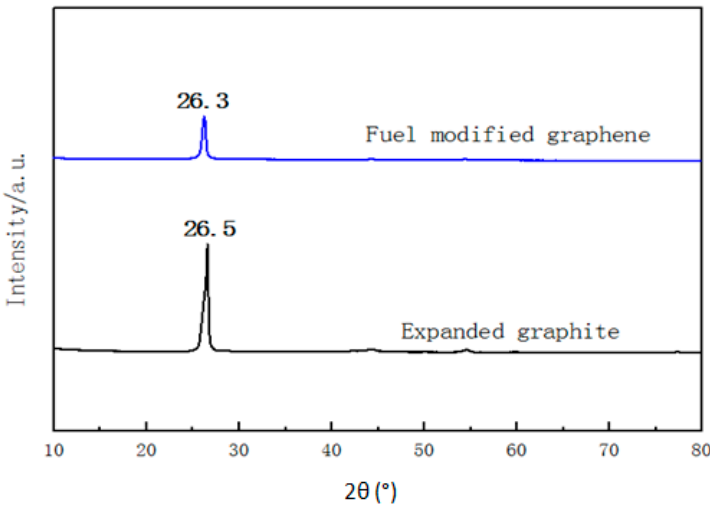
Figure 4. XRD patterns of expended graphite and fuel-modified graphene.